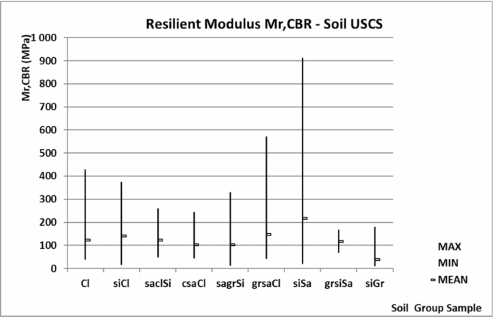
Figure 10. M r,CBR intervals for all soil